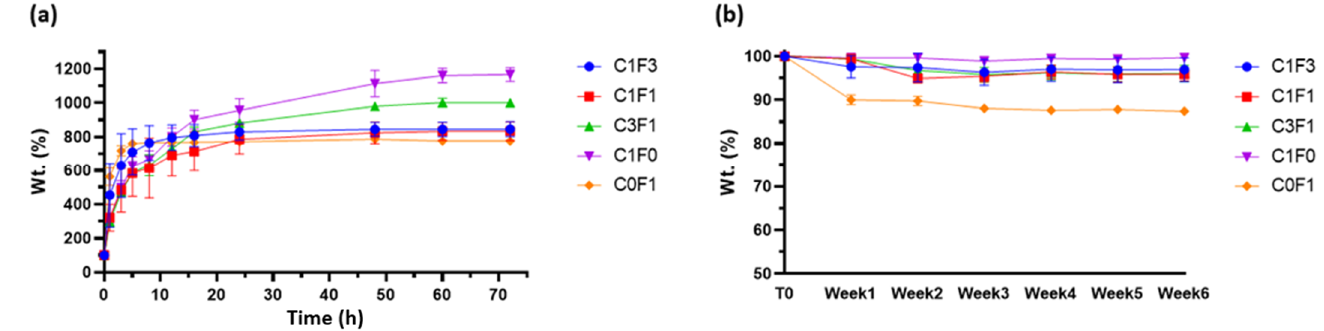
Figure 9. ( a ) Swelling profiles and ( b ) degradation profiles of fabricated hydrogels submerged in physiological PBS at pH 7.4.